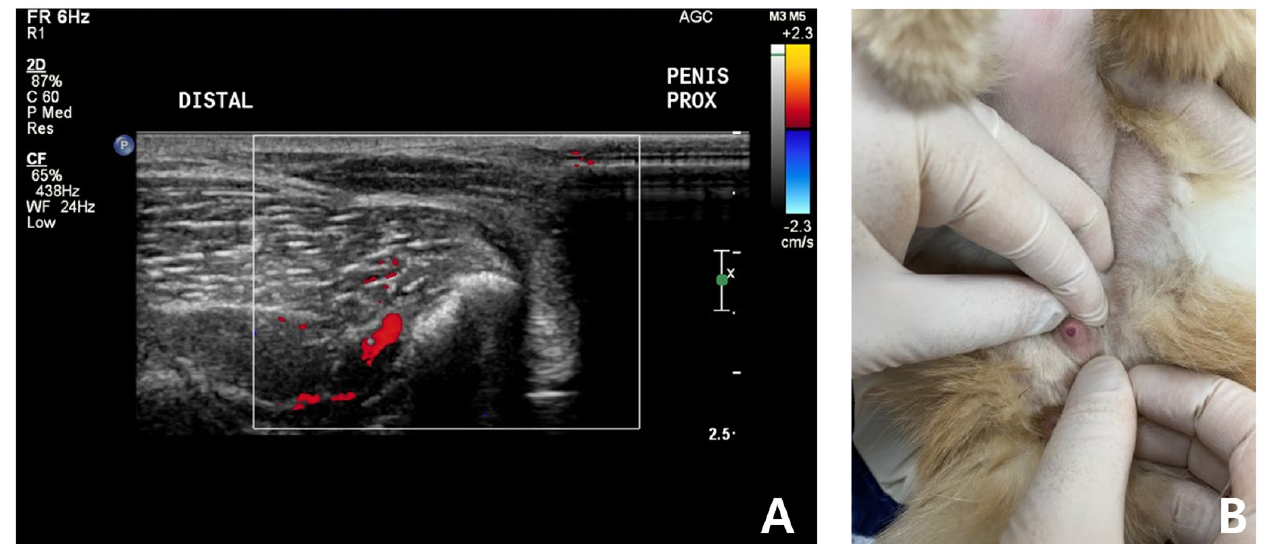
Figure 4. Follow-up ultrasound examination of a cat with non-ischemic priapism after complete clinical resolution of persistent soft erection. No significant penile cavernosal artery blood flow was detected due to the anatomical limitation of feline penis ( A ). Penis was no longer enlarged, not hard and retracted into the prepuce well ( B